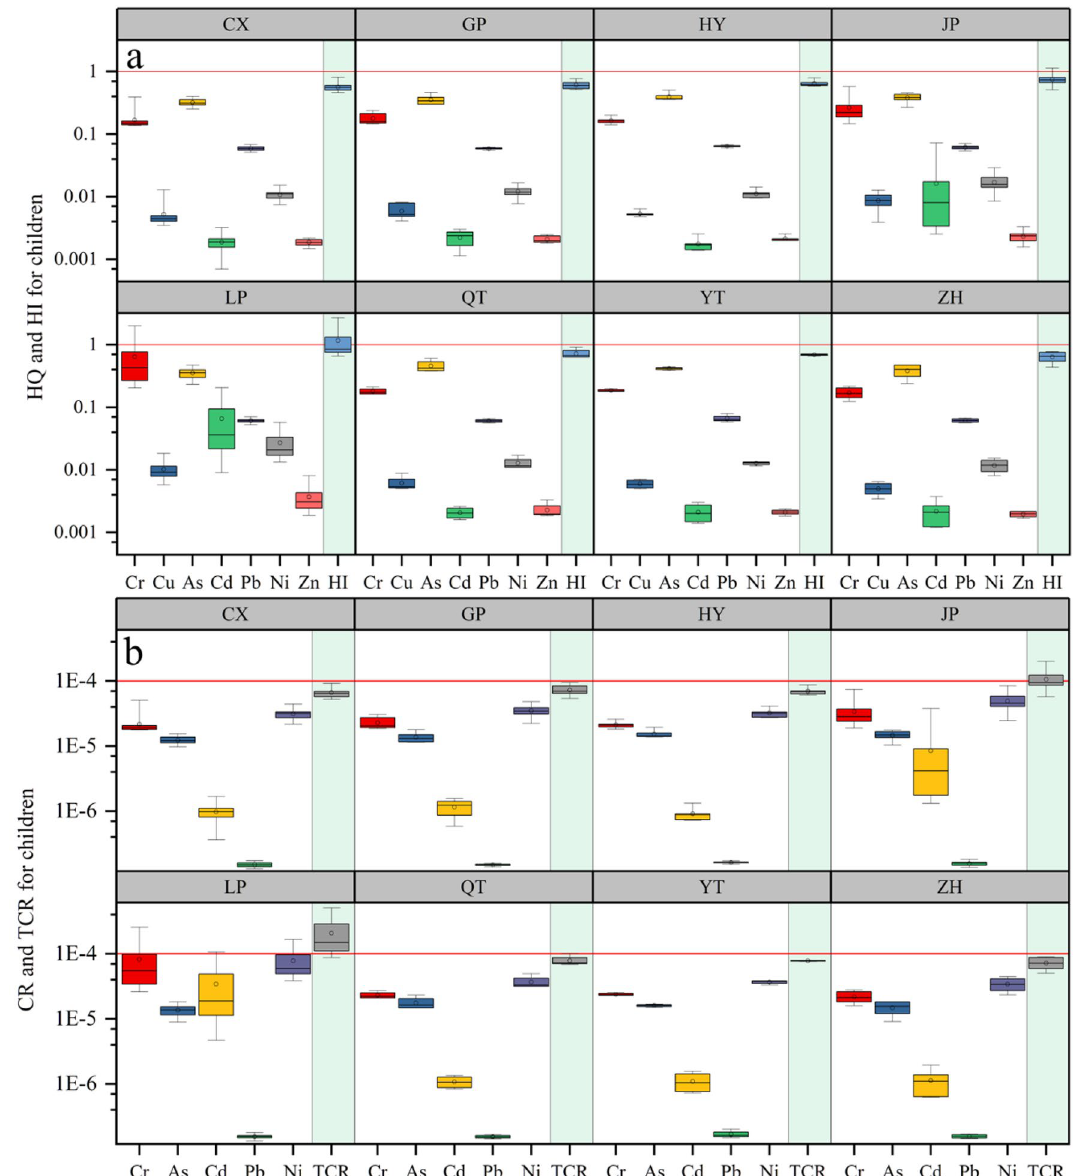
Figure 3. HQ and HI of HMs related to children ( a ), CR and TCR of HMs related to children ( b ), in eight villages. Red horizontal reference lines represent the corresponding classification criteria (1 for HQ and HI, and 1.0 × 10 –4 for CR and TCR). Boxes represent the 25th and 75th percentiles, whiskers represent the 5th and 95th percentiles, and the hollow circles represent